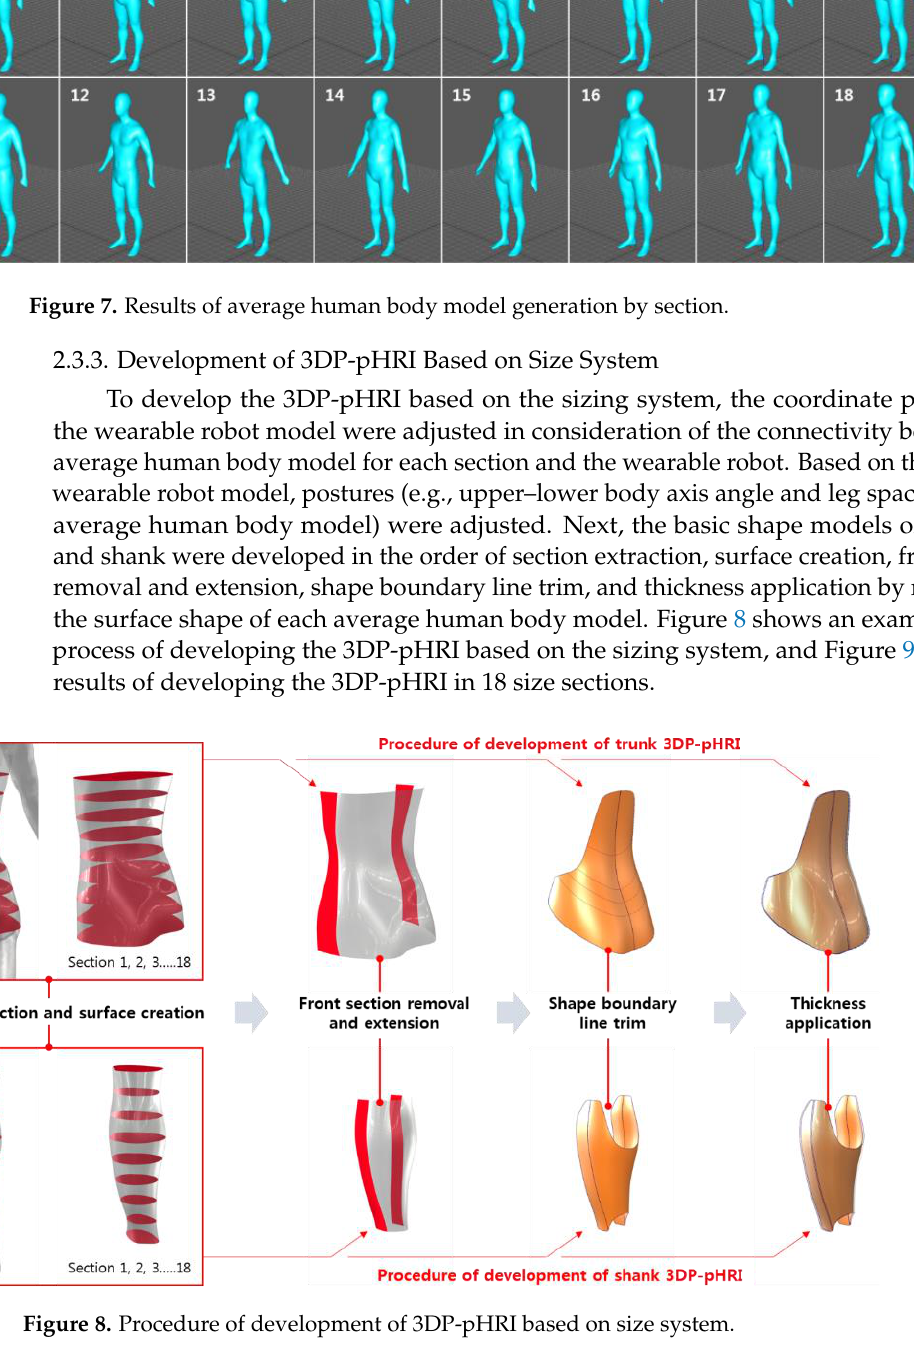
Figure 6. Process of average wireframe generation.